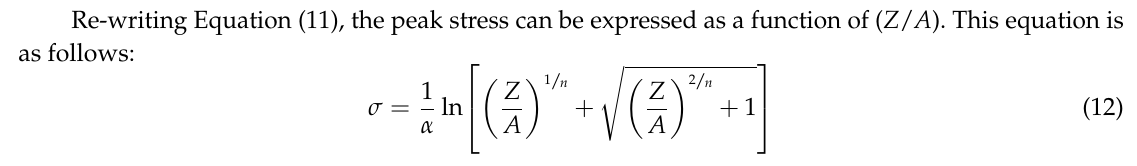
Figure 6. Correlation between log[sinh( ασ )] vs. log Z under different working conditions.